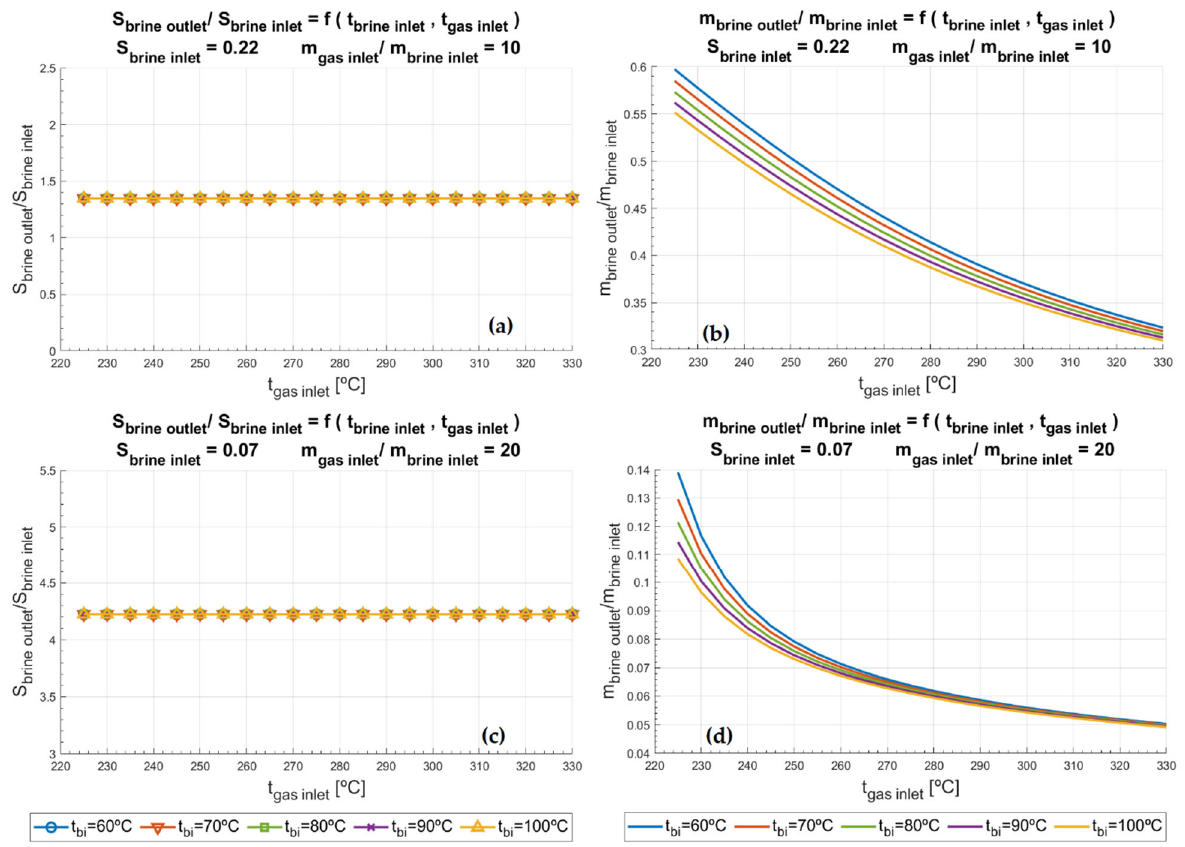
Figure 7. ( a ) Ratio between outlet and inlet brine salinities as a function of temperatures of inlet brine and inlet exhaust gases from the turbine in evaporation chamber, for S bi = 0.22 kg/kg and mg/mb = 10; ( b ) Ratio between outlet and inlet brine mass flow rates as a function of temperatures of inlet brine and inlet exhaust gases from the turbine in evaporation chamber, for S bi = 0.22 kg/kg and mg/mb = 10; ( c ) Ratio between outlet and inlet brine salinities as a function of temperatures of inlet brine and inlet exhaust gases from the turbine in evaporation chamber, for S bi = 0.07 kg/kg and m g /m b = 20; ( d ) Ratio between outlet and inlet brine mass flow rates as a function of temperatures of inlet brine and inlet exhaust gases from the turbine in evaporation chamber, for S bi = 0.07 kg/kg and m g /m b = 20.